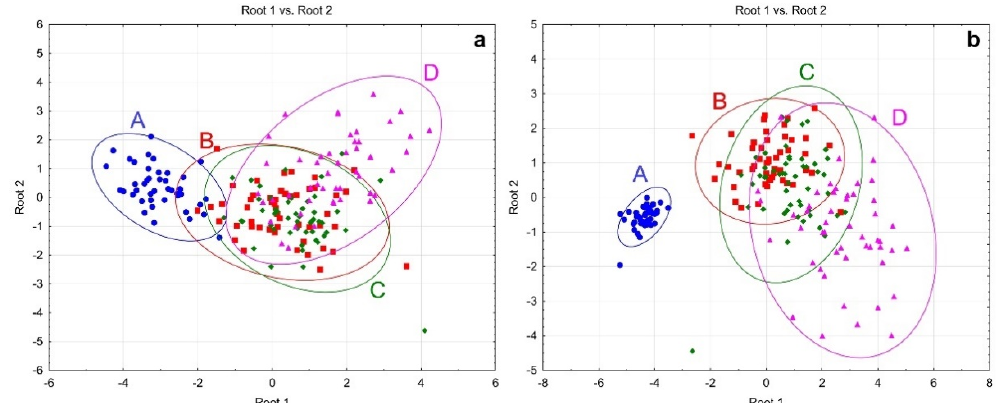
Figure 3. Scatter plot of canonical discriminant analysis based on serum metal levels ( a ) and clinical, biochemical, hemostatic parameters, as well as serum metal levels ( b ). A—control group (blue), B—Mild (red), C—Moderate (green), D—Severe (purple).